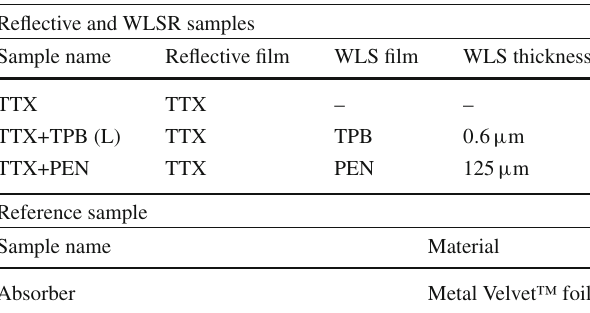
Table 2 Samples prepared for the measurements in LAr (Sect. 4). The short sample names are shown in the first column. All samples were kept in dark after their